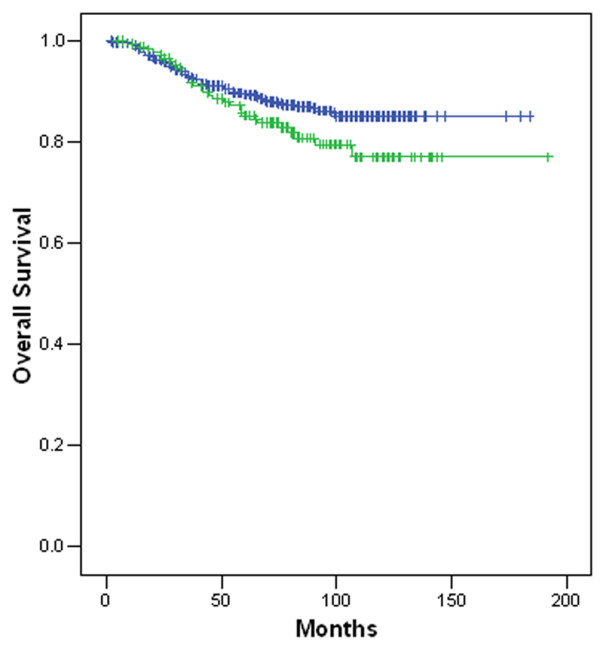
Correlation between the percentage of Lewisy/b positive tumour cells and overall survival (n = 660). Kaplan-Meier survival analysis. Comparison of breast cancer patients with a low percentage of Lewisy/b positive cells (blue curve: <25% positive cells, n = 480), and patients with >25% positive tumour cells (green curve: n = 180, p = 0.091).